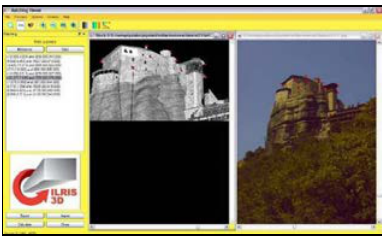
Figure 9. View of the final 3D point cloud of the monastery.